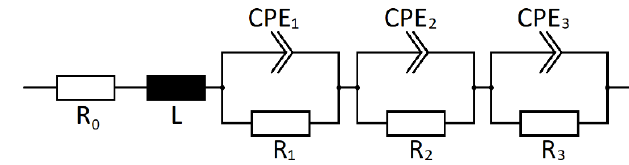
Figure 6. ECM for the EIS